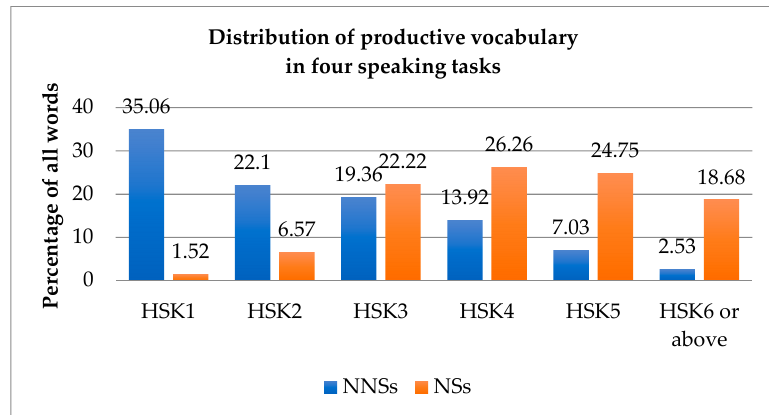
Figure 2. Distribution of words produced by second language (L2) learners (NNSs) and native speakers (NSs) based on the Hanyu Shuiping Kaoshi (HSK) difficulty ranking.